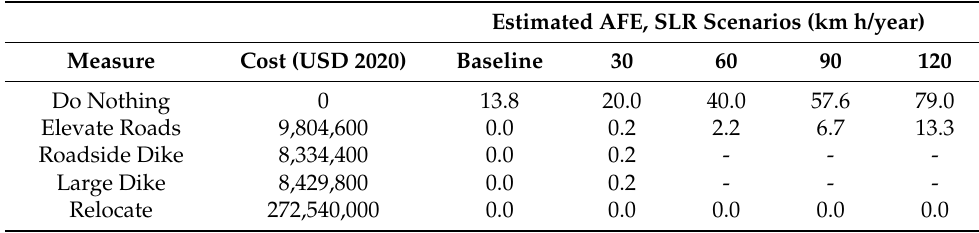
Table 10. Estimated costs and AFE for the entire